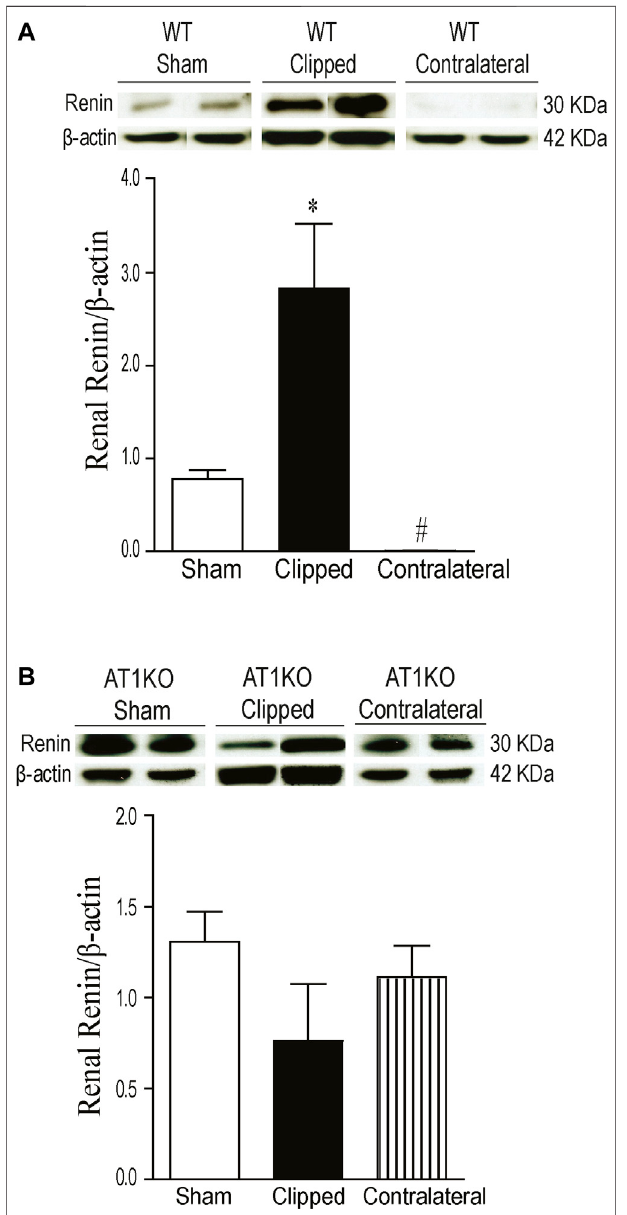
FIGURE 5 | Effect of renovascular hypertension on renal renin expression in WT and AT1KO mice after 2 weeks of 2K1C Goldblatt surgery. ( A) Renal renin protein expression in WT sham, clipped kidney and contralateral kidney. ( B) Renal renin protein expression in AT1KO sham, clipped and contralateral kidney. In each individual experiment, samples were loaded randomly in four gels. Two Immunoreactive bands from each group corresponding to renin were appropriately cropped and spliced as a representative oftheresult. One-wayANOVAshowedasigni fi cantincreaseof renal renin expression in WT clipped kidney of 2K1C mice compared to sham and contralateral kidney (* p < 0.001 vs. sham). Data are represented as mean ± SEM (n (cid:2) 6).